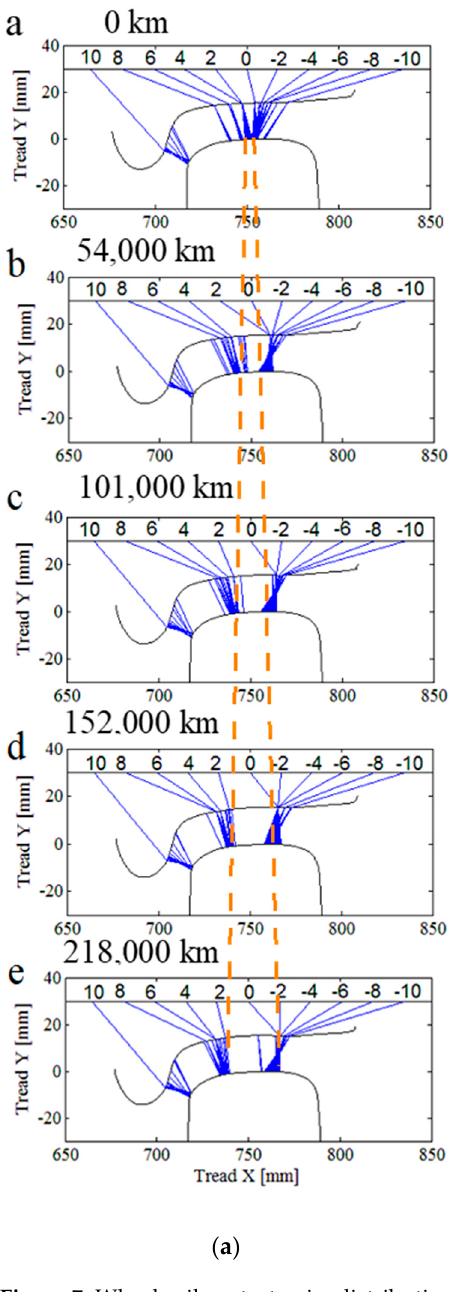
Figure 7. Wheel ‐ rail contact pairs distribution: ( a ) Line A ( b ) Line B. Figure 7. Wheel-rail contact pairs distribution: ( a ) Line A ( b ) Line